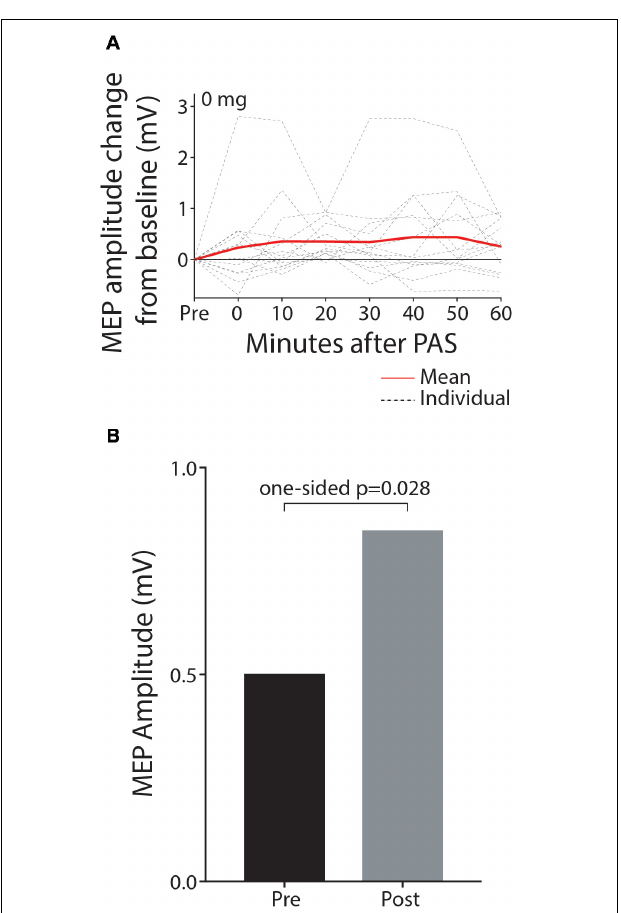
FIGURE 2 | MEP amplitude is significantly increased post-PAS intervention relative to pre-PAS amplitude in the baseline off-drug session. Data are shown depicting MEP amplitude change from baseline for individual time-points post-PAS (A) and mean MEP amplitude for pre and the hour post-PAS (B) .